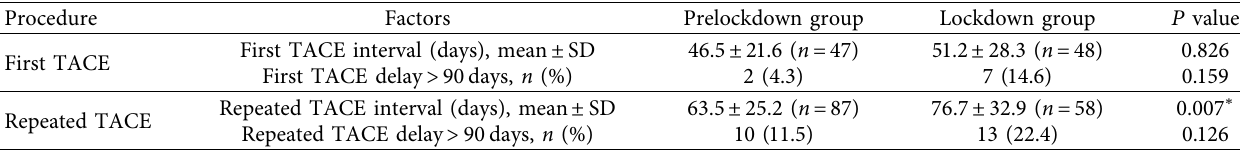
Repeated TACE TACE, transarterial chemoembolization; SD, standard